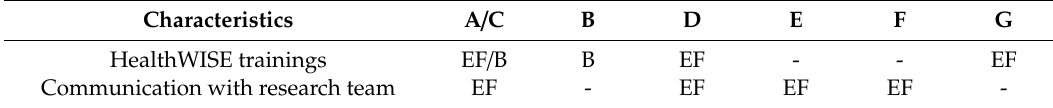
Table 5. Facilitation construct characteristics and whether they were enabling factors (EF) and / or barriers (B) to the implementation of HealthWISE in each participating hospital